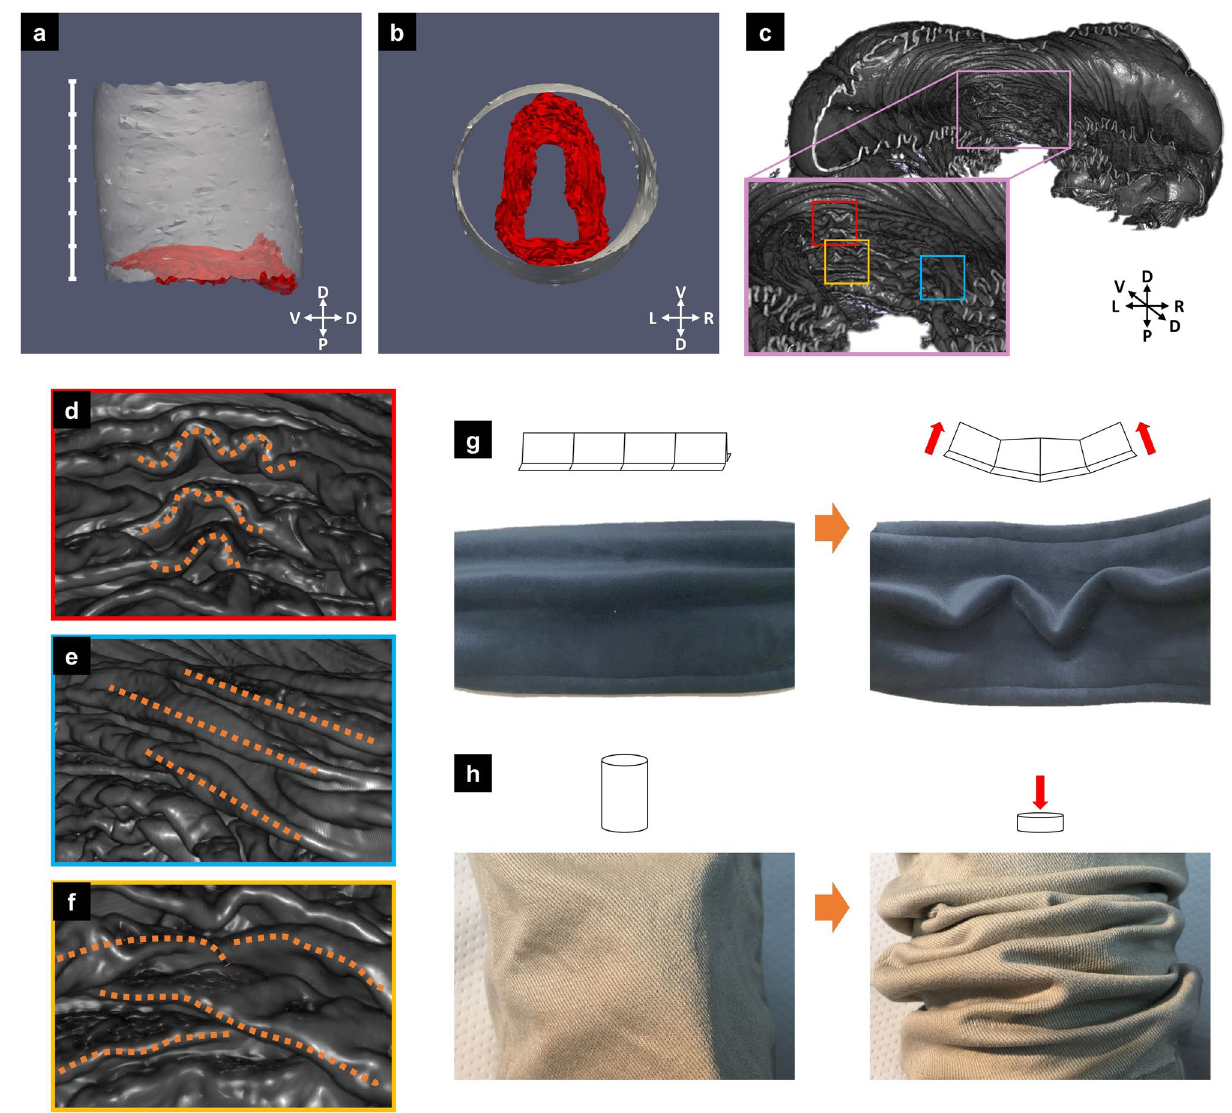
Figure 4. The folding in the stalk has features suggestive of passive formation. ( a , b ) Comparison of unfolded and folded stalks after adjusting the orientation. ( a ) The view from the left side revealed that the height of the unfolded stalk (white mesh) was about six times that of the folded stalk (red mesh). ( b ) Viewed from the top side, the folded stalk had an elongated shape that was flattened along the left–right axis. On the other hand, the dorsoventral length of the folded stalk was almost the same size as that of the unfolded stalk. ( c ) Observation of horn primordia from the inside with micro-CT. The pink window is the magnified view of the stalk. ( d – f ) Folding patterns seen in the stalk. Each colored window corresponds to the colored window in ( c ). ( d ) Wavy folding. ( e ) Straight parallel folding. ( f ) Zigzag folding. ( g ) The wavy folding ( d ) is formed passively by bending the sheet with folds. ( h ) The zigzag folding ( f ) is formed passively by longitudinal longitudinal compression, causing the zigzag folds. A wavy fold also appeared autonomously when a sheet with folds was bent (Fig. 4g). Since the lateral tips of the cap occupy both the left and right spaces beside the stalk, the growing cap is thought to exert bending forces on the ventral side of the stalk. Structure of the cap. As mentioned above, the cap is a region that generates four branches in the distal region. Figure 5a shows a superimposed drawing of the cap before and after the expansion, with the angle adjusted to the same orientation (seen from the ventral side). We then subdivided the cap into four subregions according to the characteristics of the expanded structure (Fig. 5b,c). The lateral tips were colored red, and the medial tips were colored white. The subregion between the medial tips was named “upper surface” (colored pink) and the underside of the overhangs was named “bottom surface” (colored green). Next, the area in the folded primordia corresponding to each subregion was identified in the correspondence analysis and the func- tions of the furrow were examined in the furrow removal analysis.